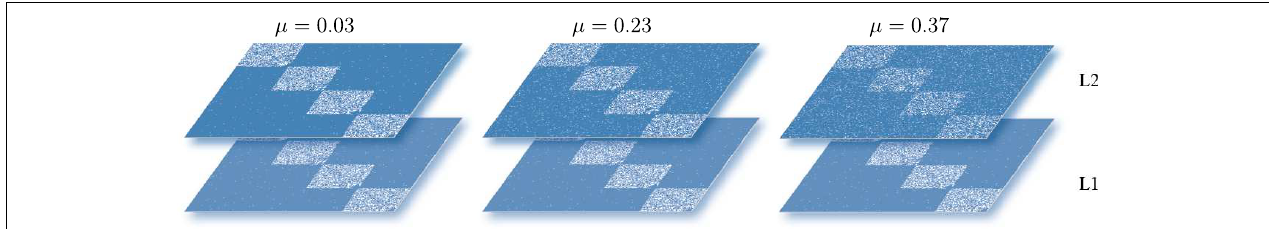
FIGURE 2 | Samples of the multiplex networks generated, represented by means of their superposed adjacency matrices. From left to right, the top layer diffuses its community structure (increasing mixing parameter), while the bottom layer remains fixed.